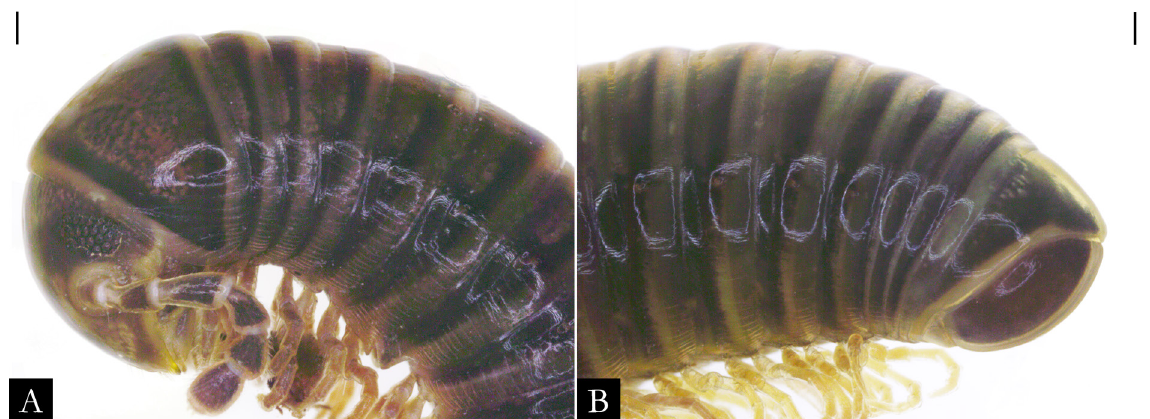
Fig. 159. Pseudonannolene nicolau sp. nov., paratype, ♂ (ABAM), in lateral view. A . Anterior region. B . Posterior region. Scale bars = 0.2